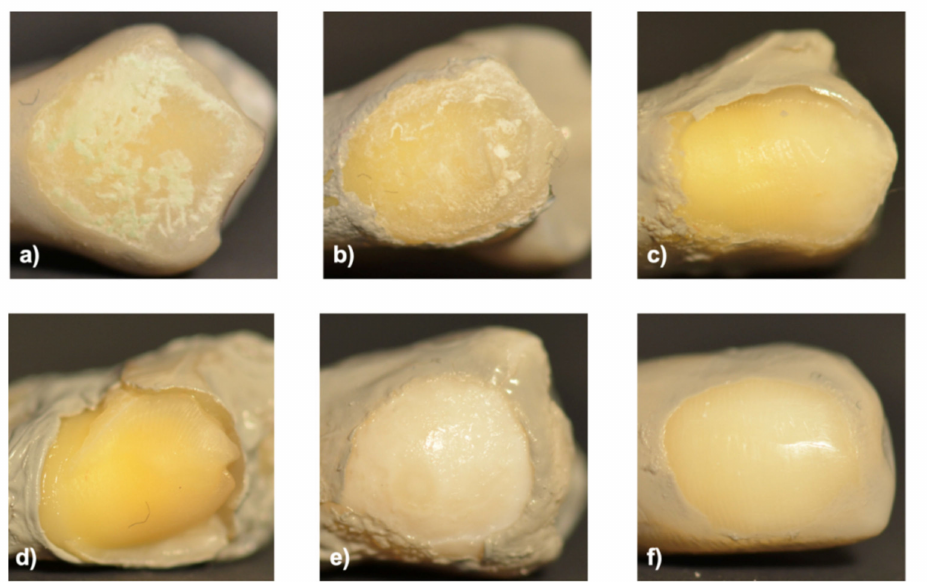
Figure 5. The enamel after being placed for 96 h in: ( a ) hydrochloric acid; ( b ) orthophosphoric acid; ( c ) lactic acid; ( d ) orthophosphoric acid solution; ( e ) formic acid; ( f ) CaCl 2 , NaH 2 PO 4 and acetic acid